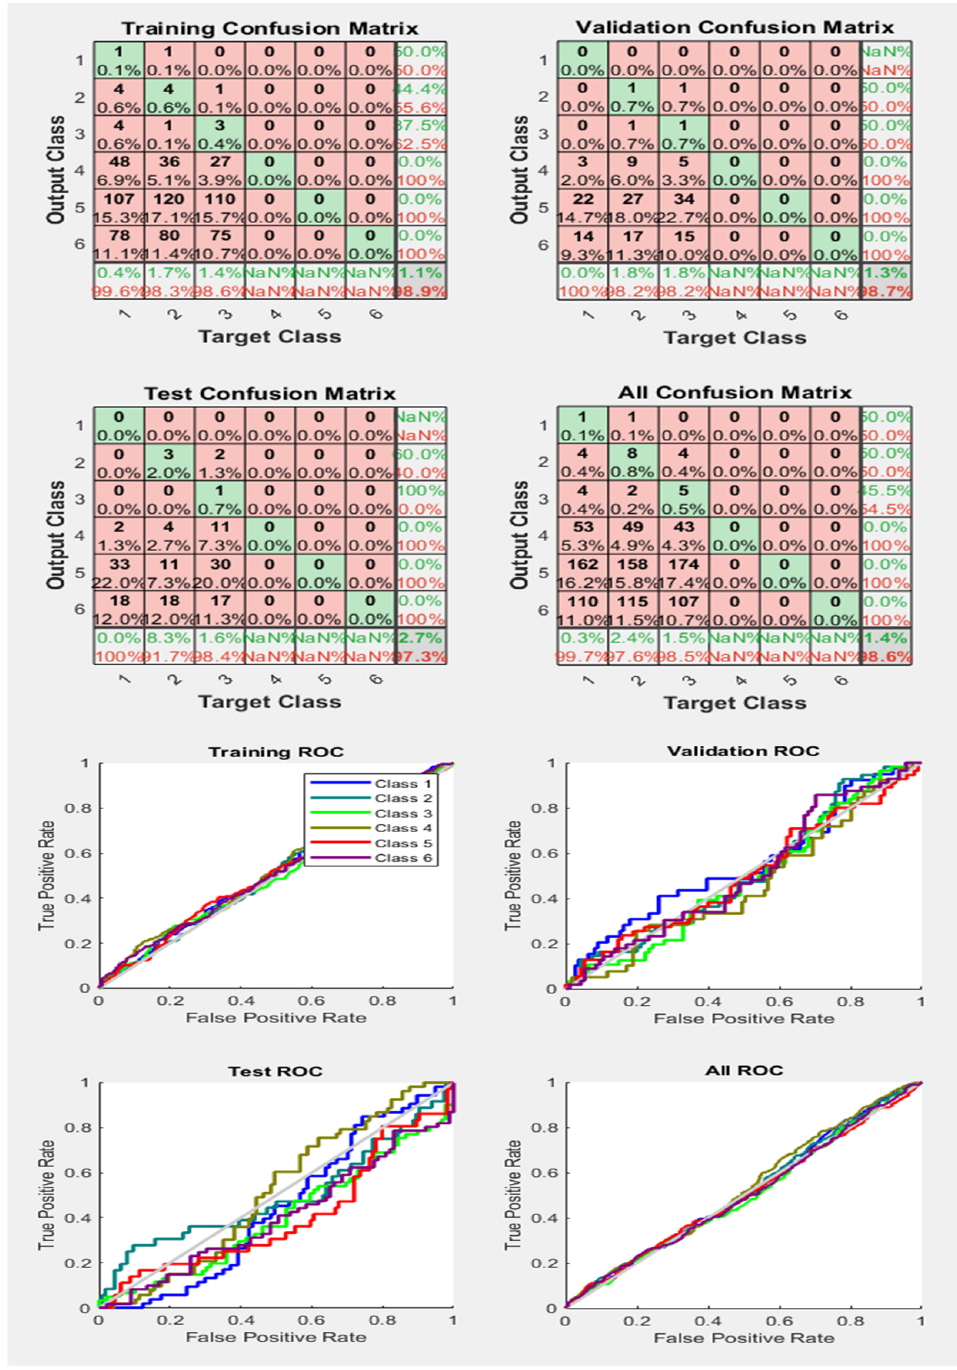
Figure 27. Neural Network Model ROC (Receiver Operating Characteristics) and Confusion Matrix for LM TrainFcn/Activation Function at level 9 (RMS) Features for Rotor Bar Fault with 98.6% Accuracy. Grey line shows diagonal of the ROC for indicating Class 1–6 lines are lying above or below or on it.